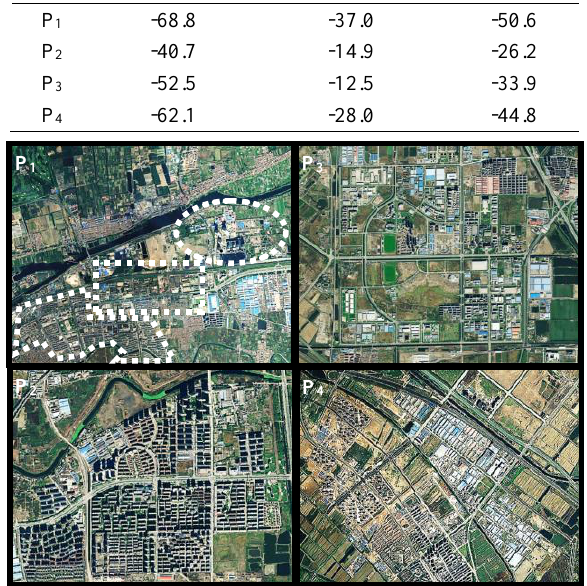
Fig. 4 Optical images related to P1, P2, P3 and P4, respectively thermal power plant (marked by the dashed oval), multiple industrial factories (marked by the dashed rectangle) and some residential quarters (marked by the dashed polygon), and